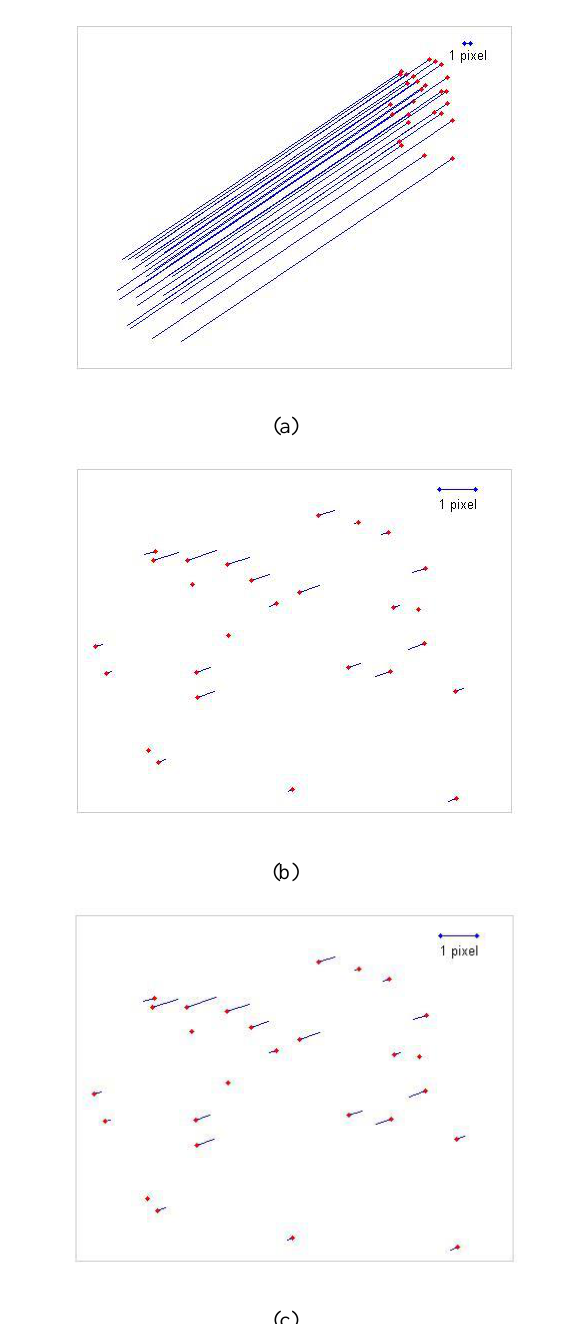
Figure 4. Relative pointing error of QuickBird data: (a) before orientation (b) relative bias-compensated method (c) global relative pointing error